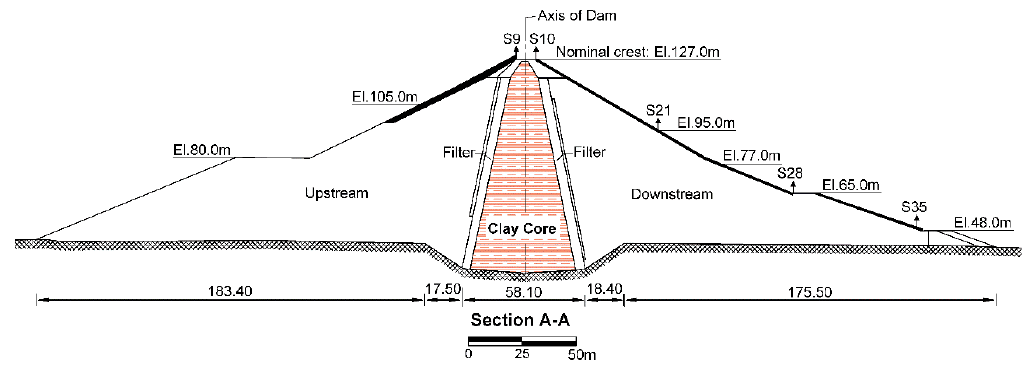
Figure 2. Maximum cross-section A-A of the Pournari I dam. For location, see Figure 3 (after [8]).